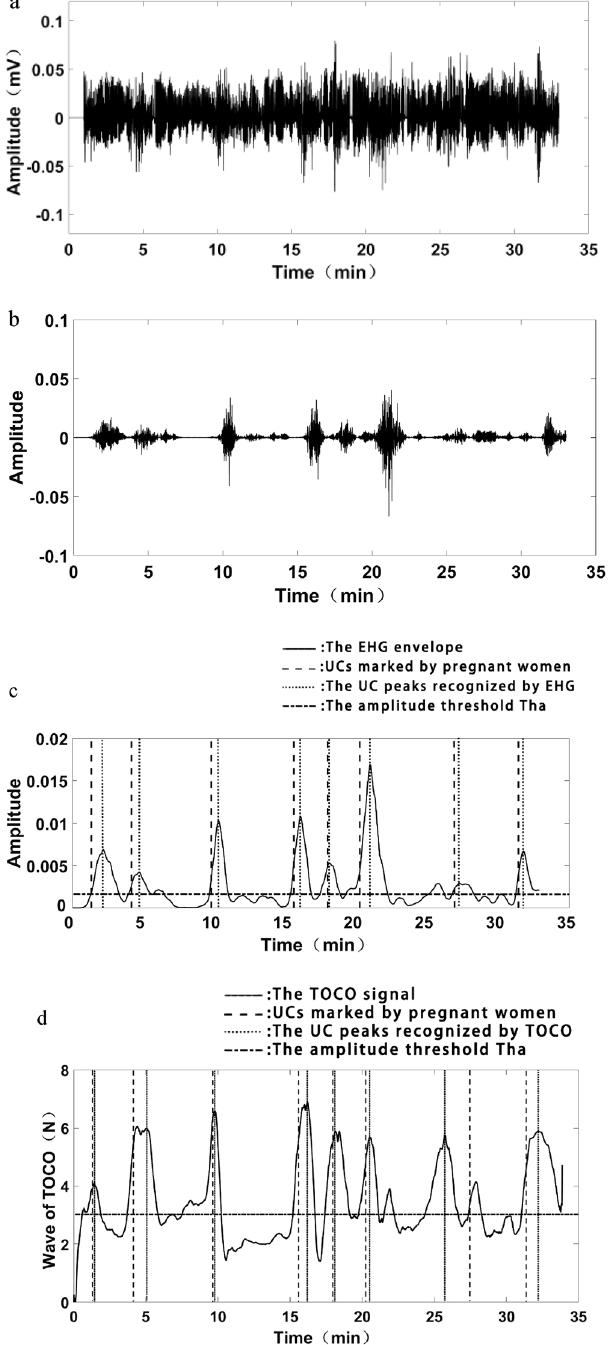
Figure 6. Recognition of UCs with EHG and TOCO. ( a ) Preprocessed EHG signal. ( b ) The modulated EHG signal. ( c ) Recognition of UCs with EHG envelope. ( d ) Recognition of UCs with TOCO